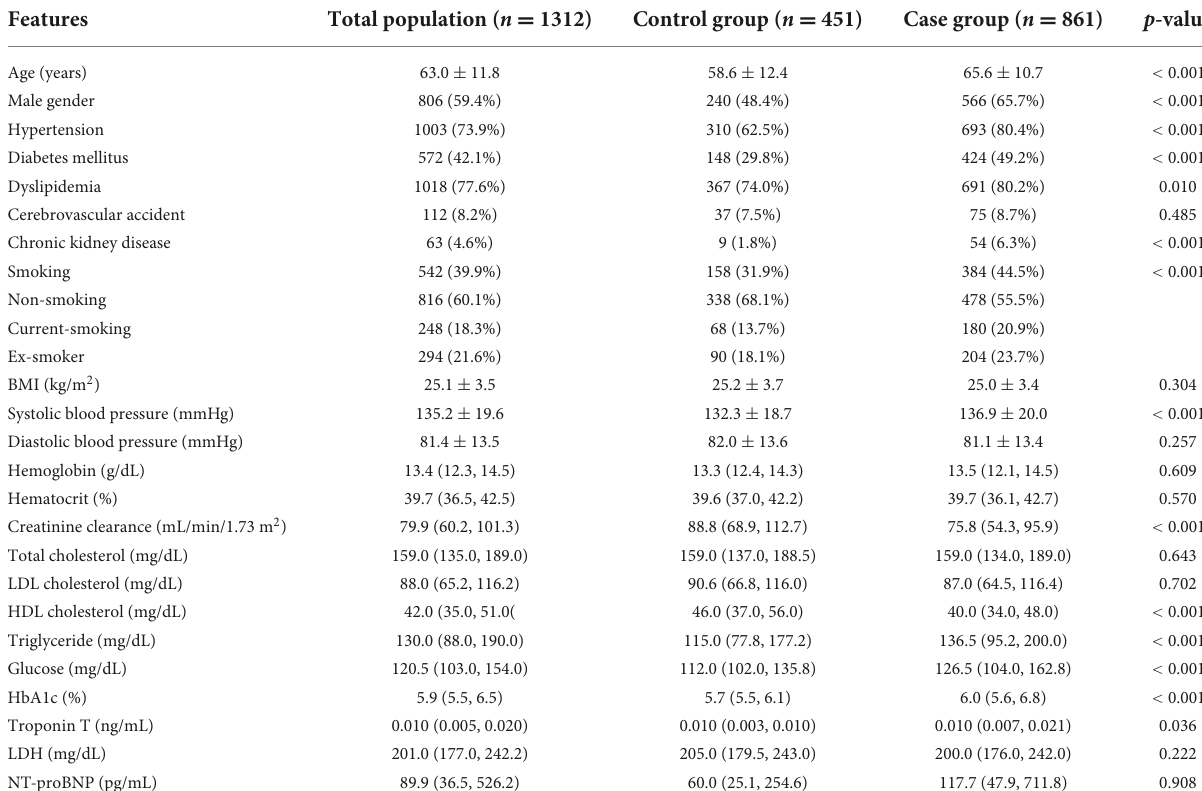
TABLE 1 Baseline characteristics.